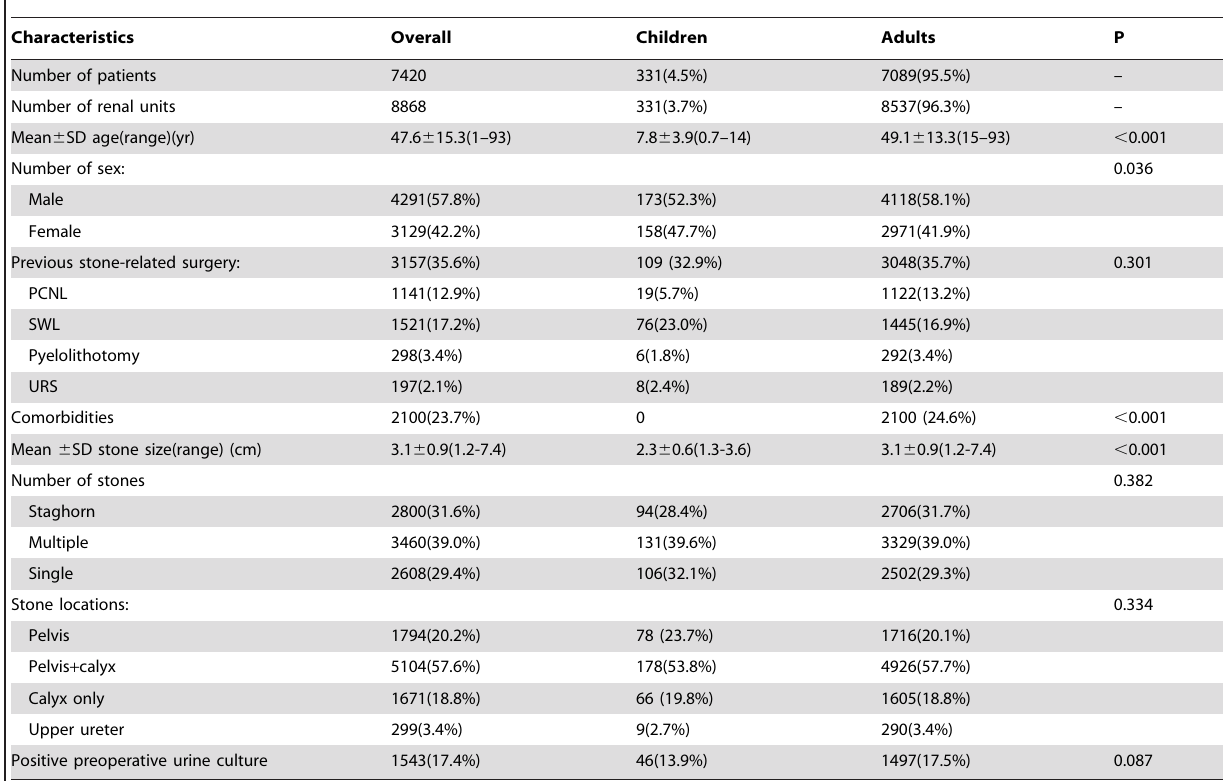
Table 1. Demographic and clinical preoperative